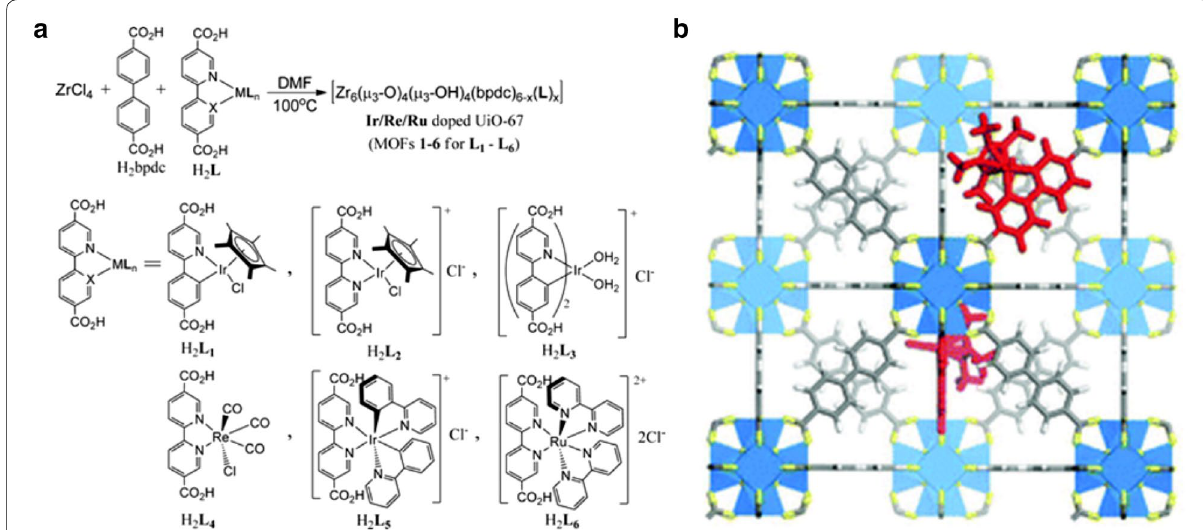
Fig. 4 a Synthesis of organometallic catalysts doped UiO‑67 . b Structure of L1 -doped UiO‑67 . The inset photo shows absorption colors. Copyright permission from ACS.